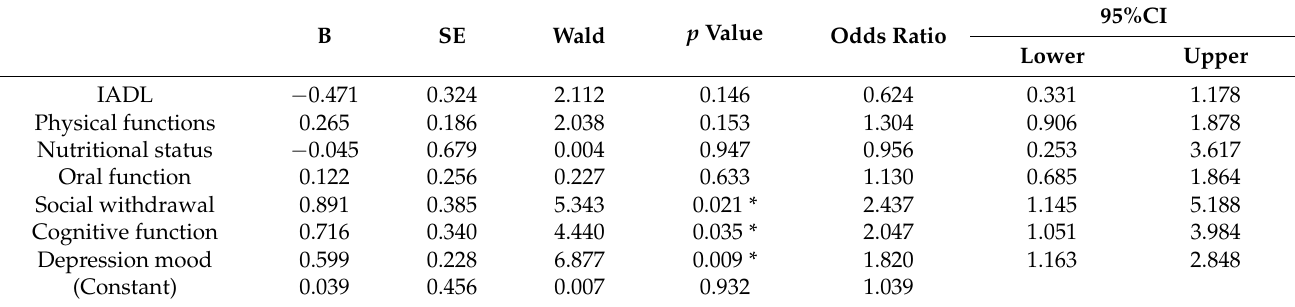
Table 5. Kihon checklist subordinate items affecting the presence or absence of eye